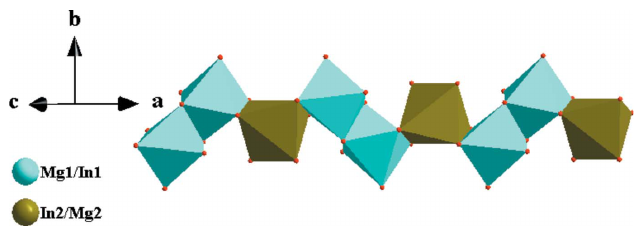
Figure 3 Edge-sharing [(Mg/In)2O 6 ] octahedra and [(Mg/In)1) 2 O 10 ] dimers forming an infinite chain extending parallel to [001]. Data taken from (I).